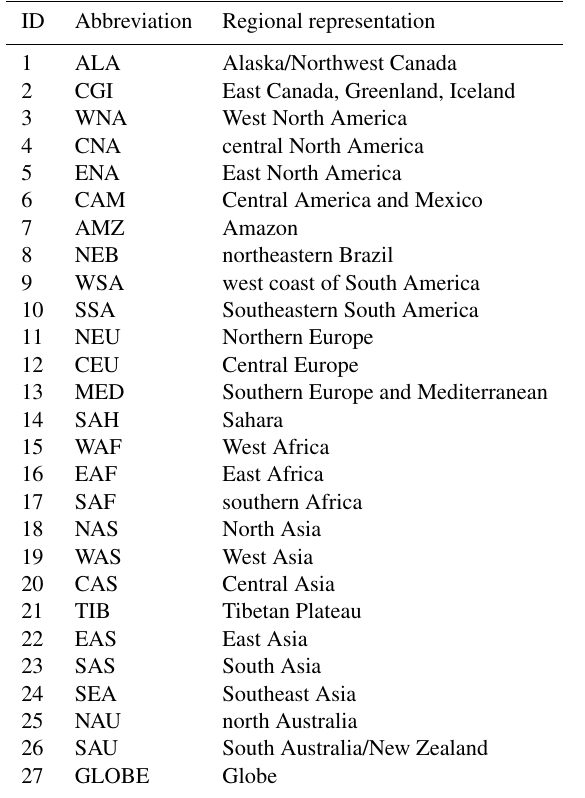
Table 2. Definition of regions in this study, after IPCC